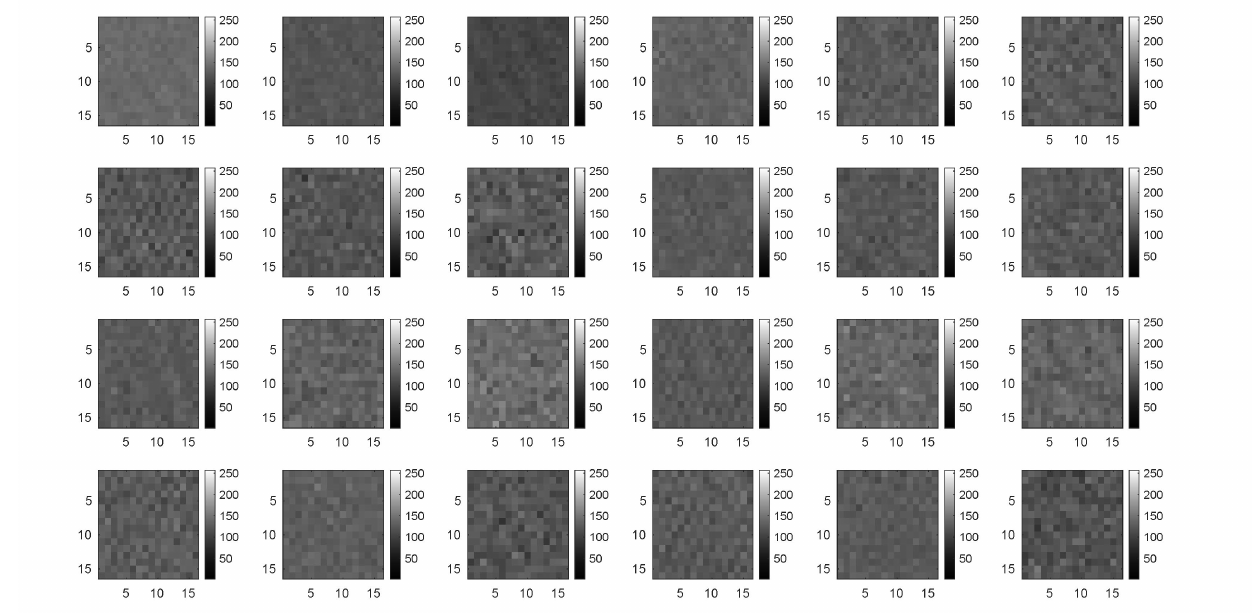
Figure 4. Multichannel gray-scale image corresponding to the 24 sensors (size 16 ×